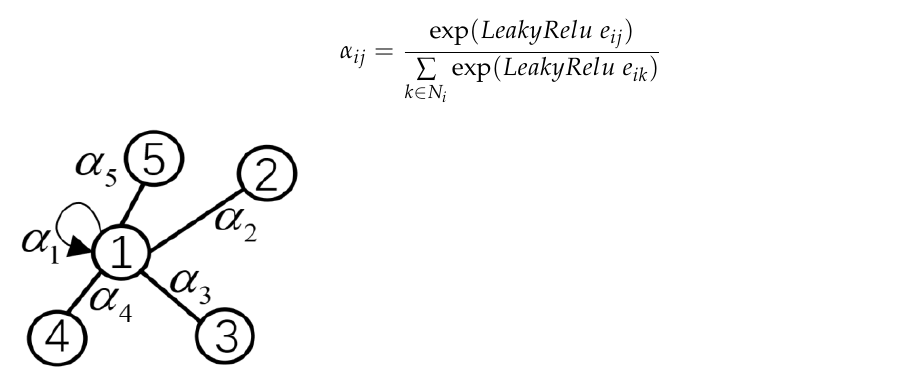
Table 1. Data sets.